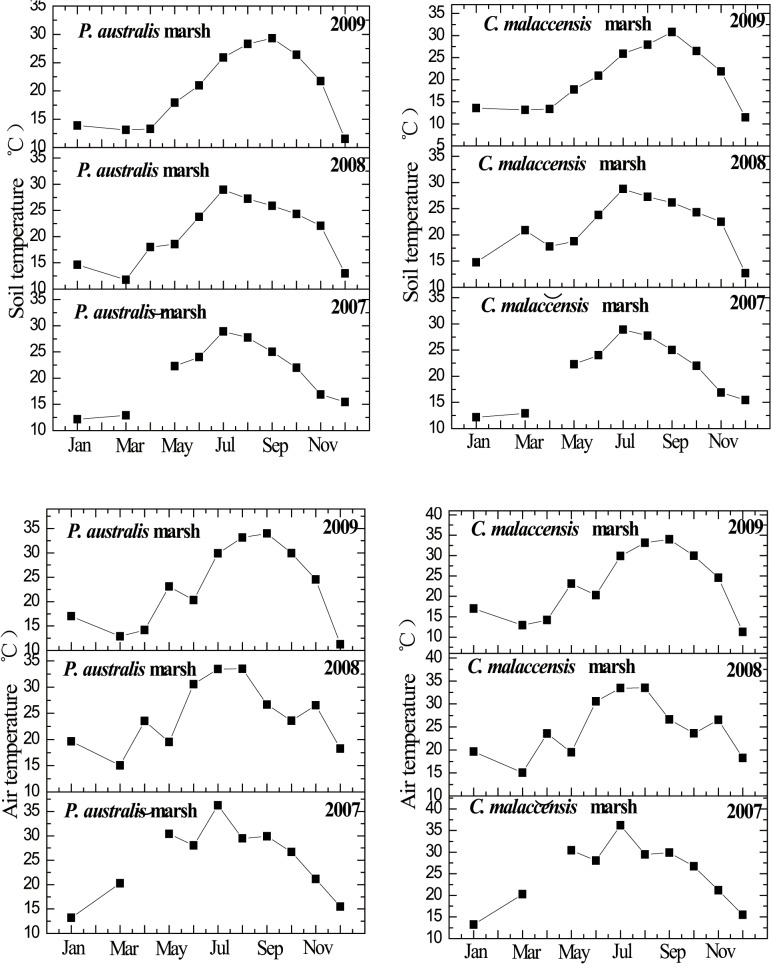
Monthly mean soil temperature (°C) at 10 cm depth or air temperature (°C) in the two marsh stands from 2007 to 2009.Data of soil (air) temperature was missing in April 2007 due to instrument failure.